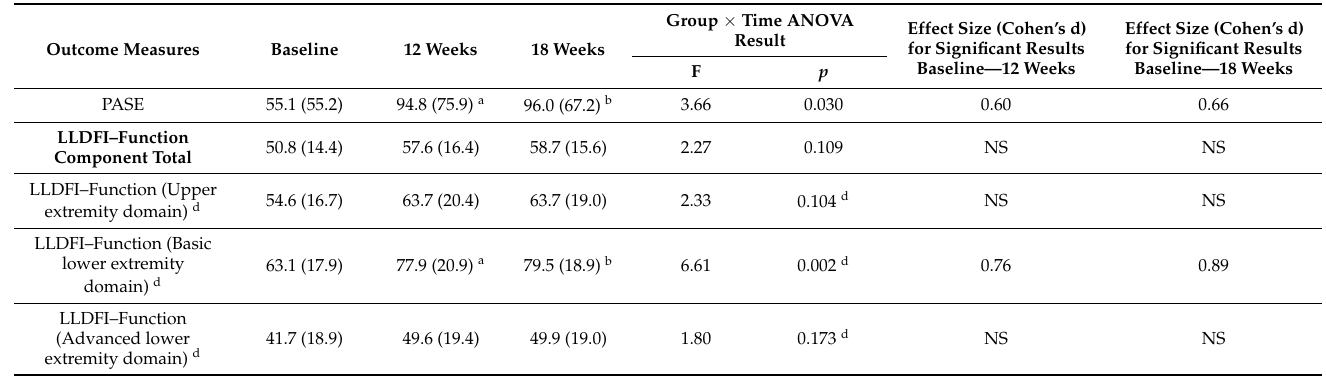
Table 4. One way ANOVA results for outcome measures across three time points—mean (SD), F value, p value and effect size c